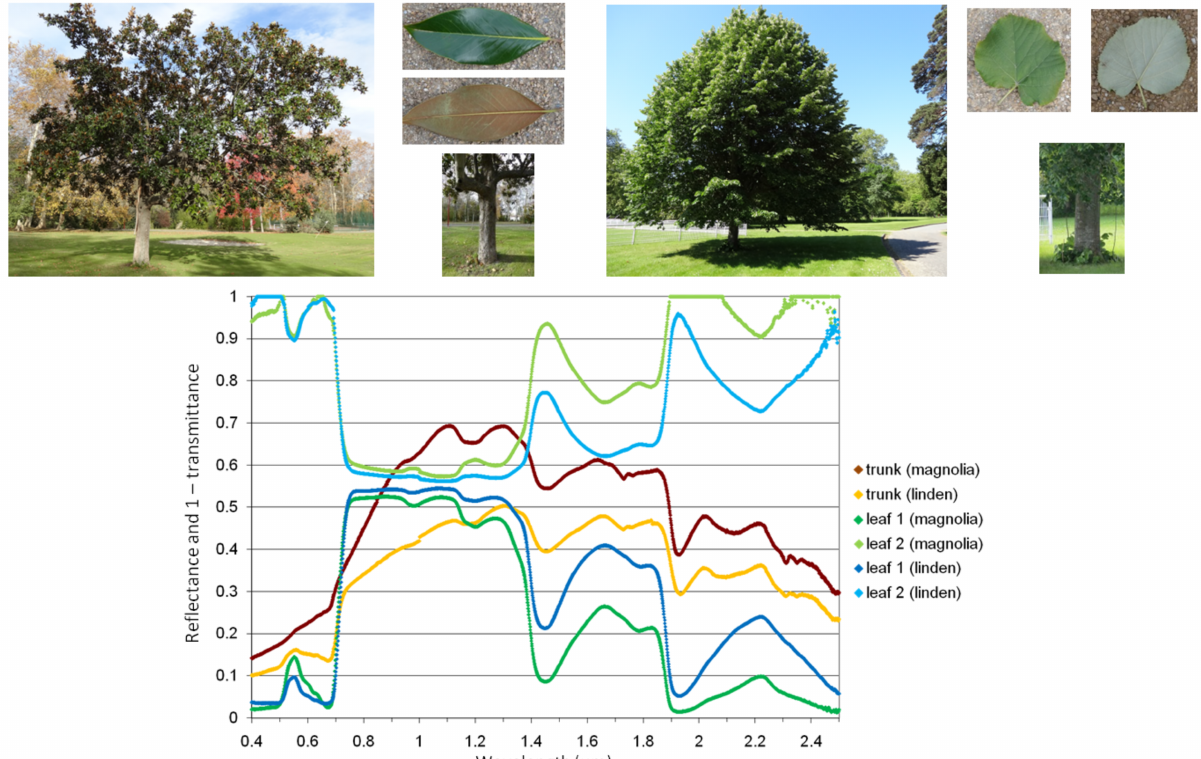
Figure 1. Digital camera pictures of the two trees (top left side: magnolia; top right side: linden) and mean spectral properties of their trunk and leaves (bottom side: “leaf 1” stands for reflectances and “leaf 2” stands for 1 −